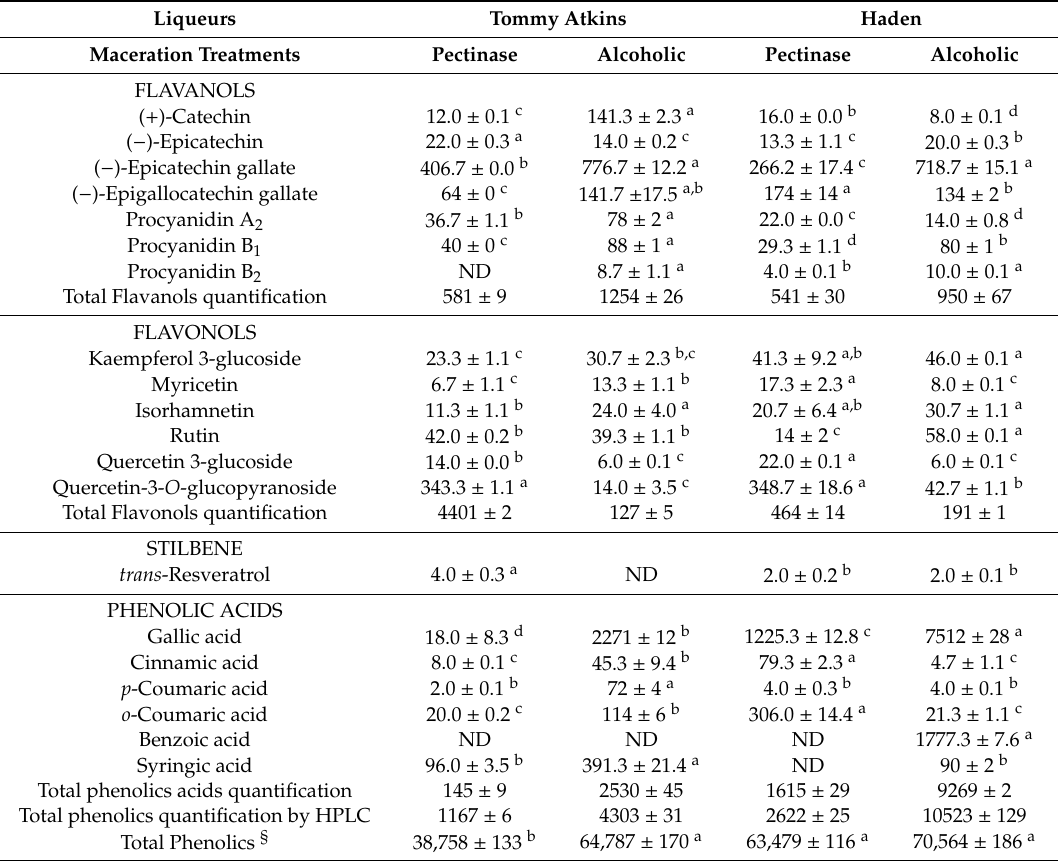
Table 2. Bioactive compounds profile ( µ g 100 mL − 1 ) of mango peel liqueurs produced by di ff erent methods of